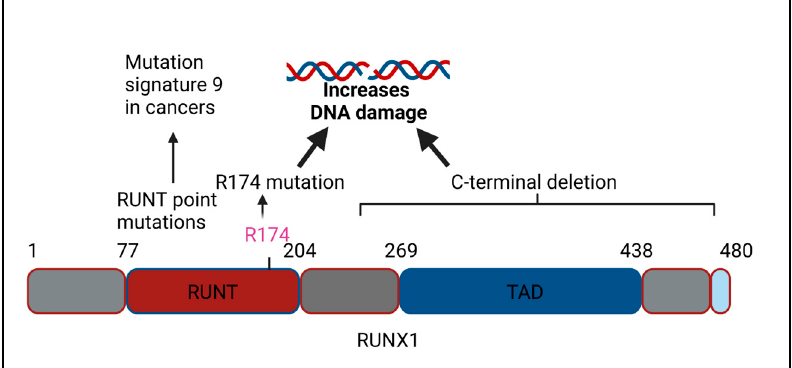
Figure 2. RUNX1 deletions, mutations, DNA repair, and cancer. A C-terminal deletion mutant of RUNX1 (RUNX1dc), as well as the DNA-binding point mutant of RUNX1 (R174Q), has been shown to increase DNA DSBs in the cells. Moreover, RUNT domain point mutations in blast crisis CML induce the mutational signature 9, which is attributed to polymerase η and AID activity during somatic hypermutation (SHM).